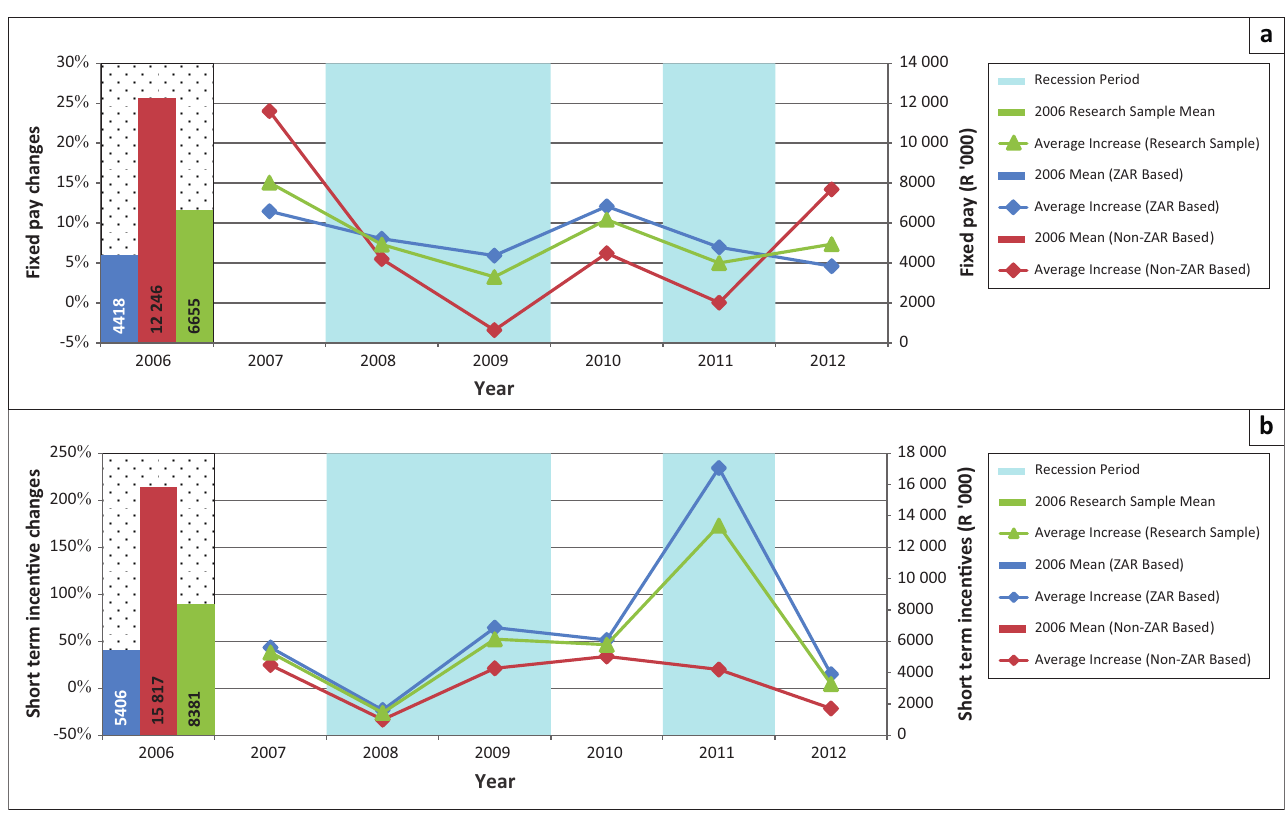
n = 21. FIGURE 4: CEO fixed pay (a) and short-term incentive (b) means and percentage changes.